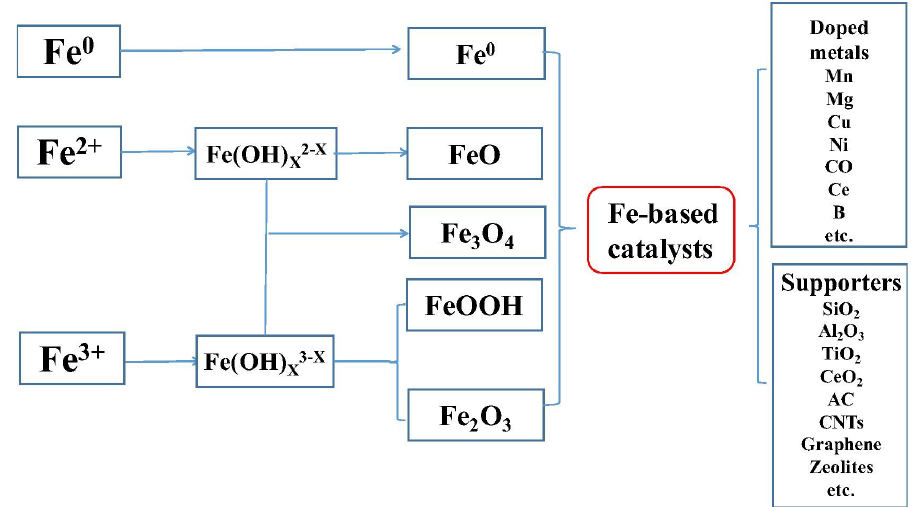
Figure 3. A variety of Fe-based catalysts. Reproduced with permission from Ref.